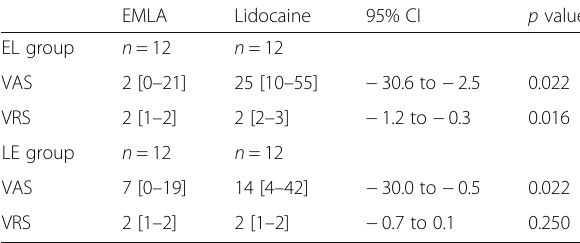
Table 2 Subgroup analysis for pain